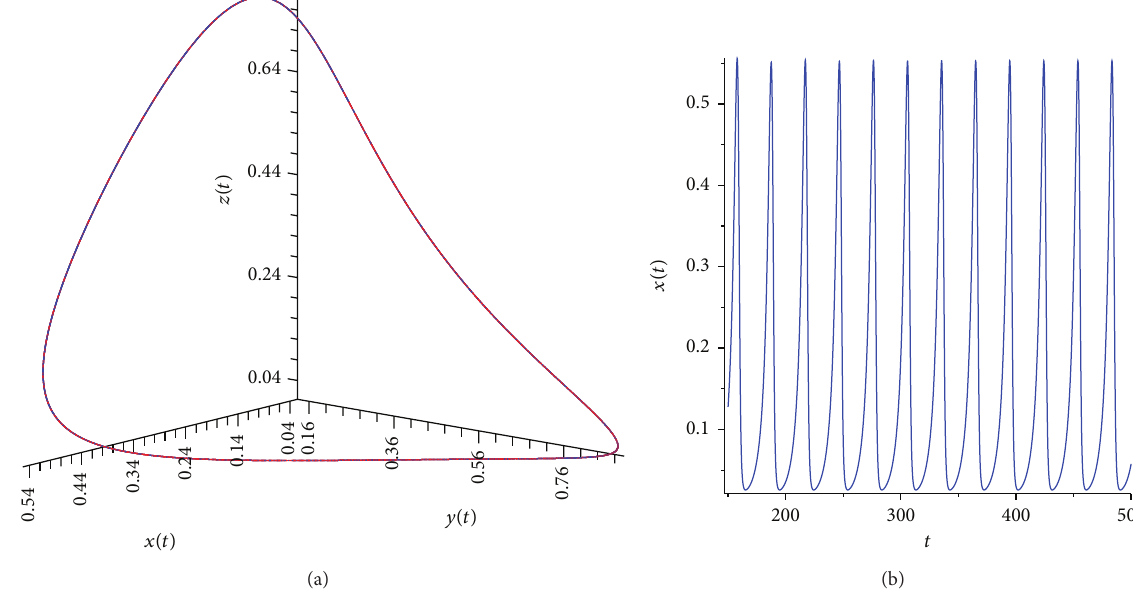
Figure 3: Periodic orbit of period 𝑇 created by the Hopf bifurcation that occurs at the equilibrium point 𝐺 . (a) Limit cycle for system (1), for 𝑎 = 0.9 . Integration time: [1500, 1600] . Initial conditions: (0.1325, 0.6687, 0.19) , (0.13,0.6, 0.2) . (b) Periodic behaviour of the coordinate 𝑥(𝑡) of the solution in (a). Integration time: [1500, 1600] . Initial conditions: (0.1325, 0.6687, 0.2) .